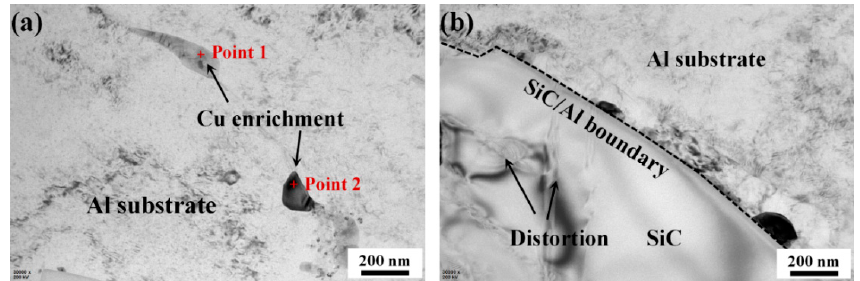
Figure 3. Typical transmission electron microscope (TEM) images illustrating microstructural mor- phology in the BM specimen. ( a ) The original aluminum substrate with Cu enrichment and ( b ) initial SiC particle with slight distortion inside and crack free SiC/Al boundary. Table 2. Chemical compositions and possible phases of the Cu enrichment in Figure 3a (at. %).